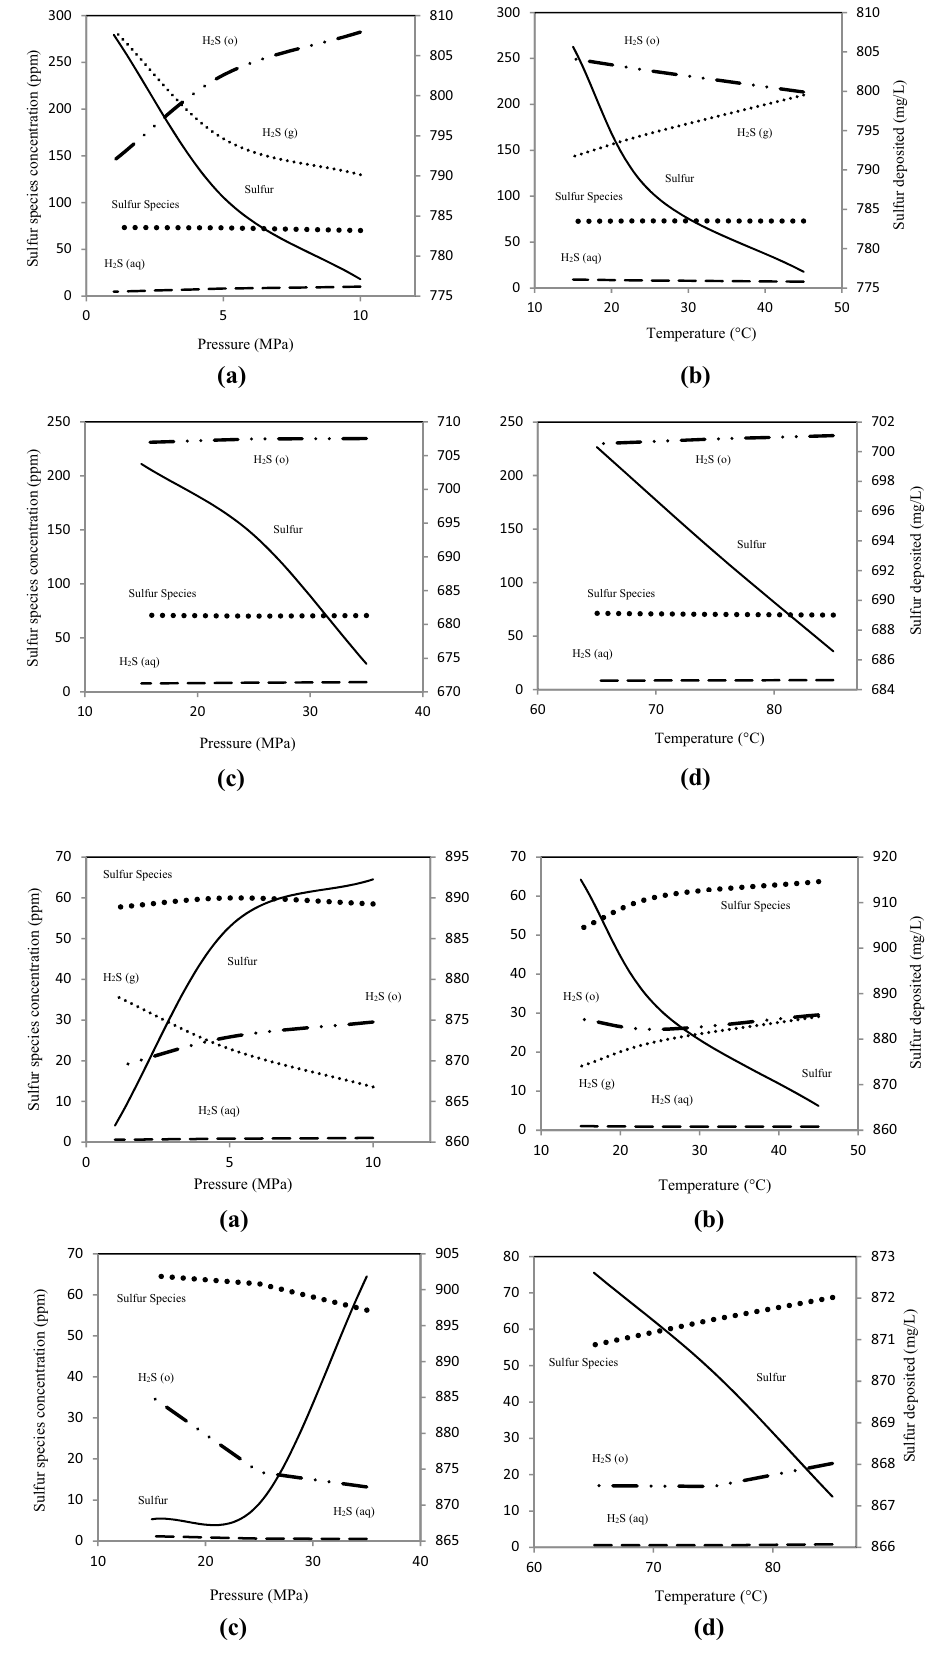
Fig. 3 The effects of tem- perature and pressure on sulfur speciation, solid-phase formation, and H 2 S partitioning, aqueous-phase reactions, initial pH: 9, a T : 25 °C, b P : 1